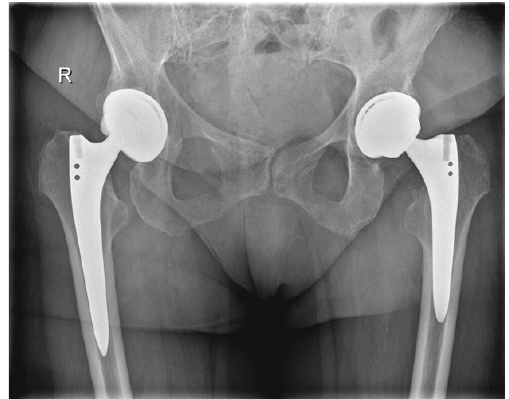
Figure 2: Postoperative X-ray showing left total hip arthroplasty.